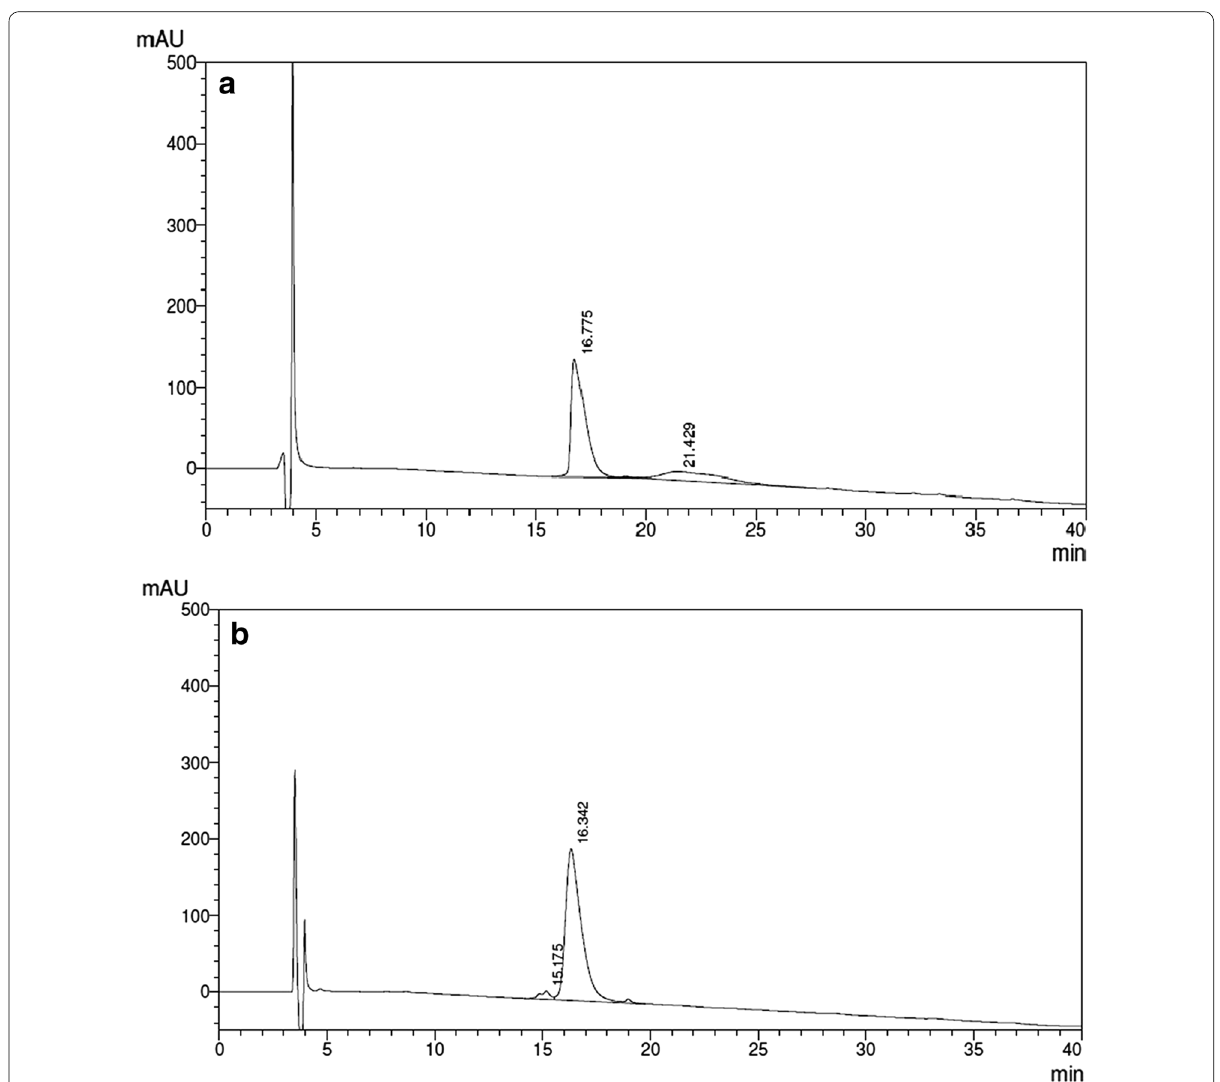
Fig. 2 Reversed-phase high-performance liquid chromatography (RP-HPLC) of: a E. coli -derived met-hBMP-2 (GenScript), 10 µg; b CHO-derived hBMP-2 (Infuse ® ), 10